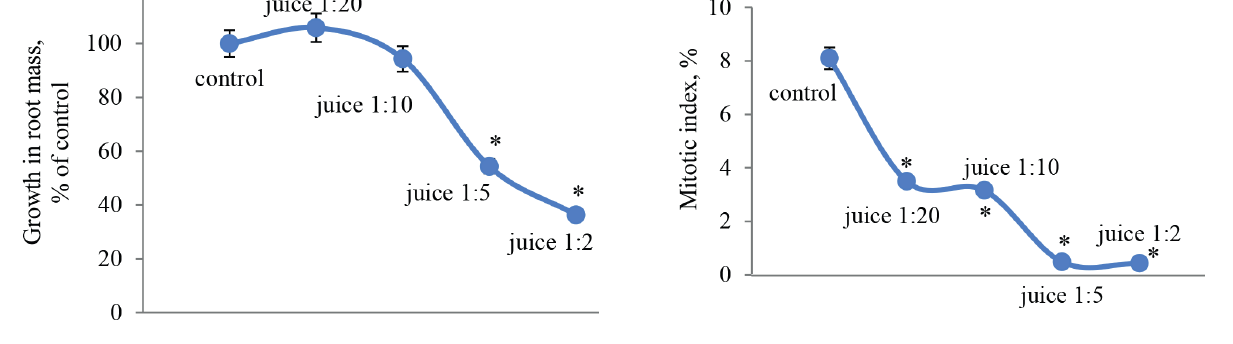
Figure 1 Growth in root mass after treatment with apple juice in different concentrations (n = 10). * P ≤ 0.15